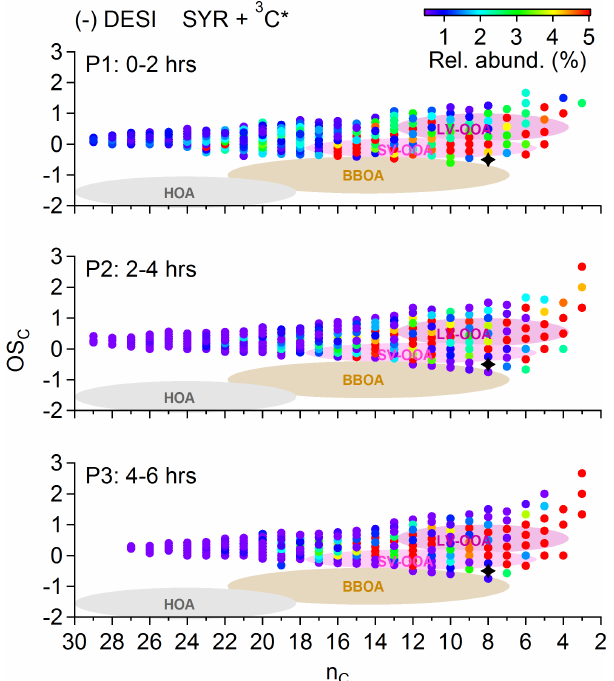
Figure 3. OS C and n C of molecules in SYR aqSOA formed dur- ing different stages of 3 C ∗ -mediated reactions determined based on (–) nano-DESI MS spectra. Signals are colored by the relative abundance of the molecules. The black star at n C = 8 represents SYR. The shaded ovals indicate locations of different ambient or- ganic aerosol classes reported in Kroll et al. (2011).